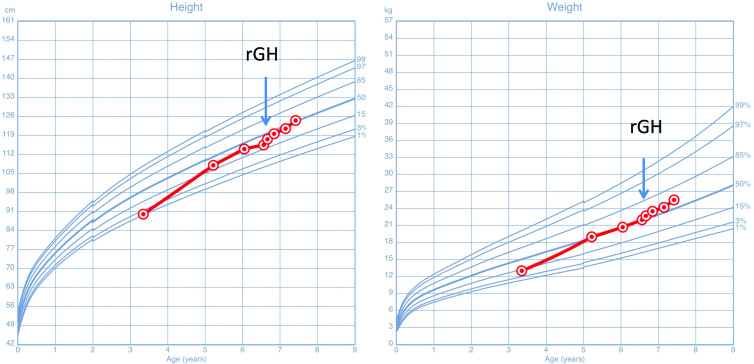
Growth condition before and after rGH therapy in patient-3. Source: Child Growth Standards (0–5 years), 2006, World Health Organization. Growth Reference (5–19 years), 2007, World Health Organization.